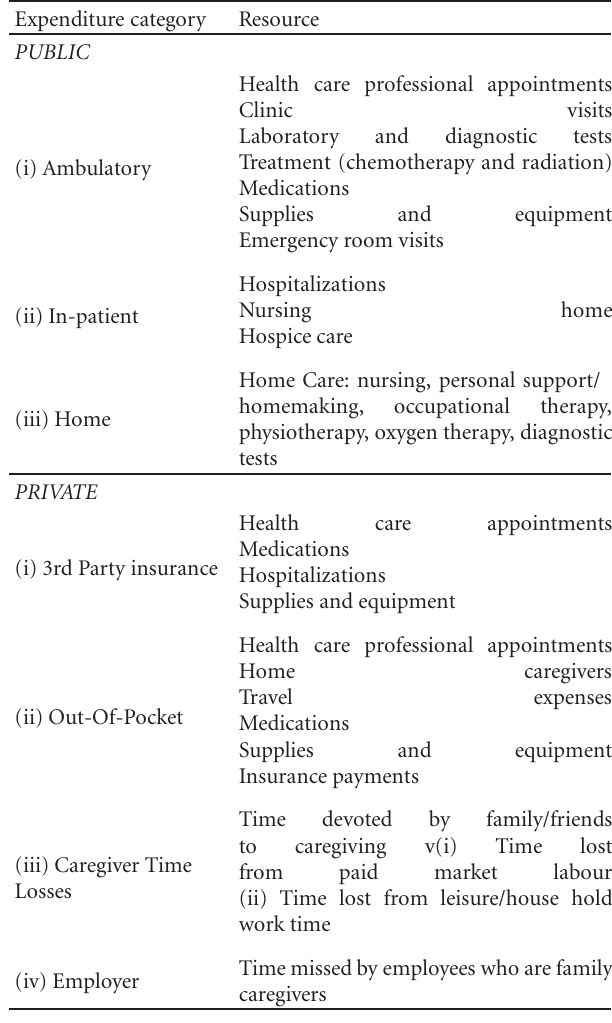
Table 2: Framework for the assessment of end-of-life